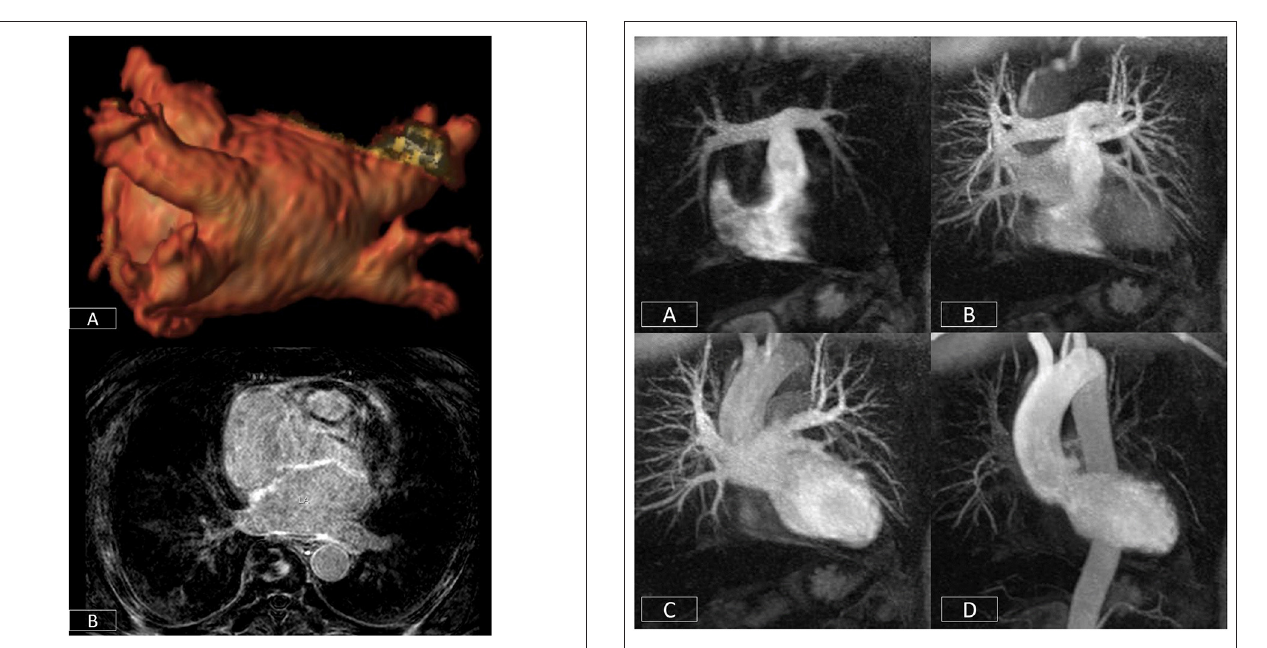
FIGURE 7 | Cardiovascular time resolved 3D-angiography. The bolus of contrast is imaged progressively as it passes from the right side of the heart (A) into the pulmonary arteries (B) , left atrium/ventricle (C) , and thoracic aorta (D) . This obviates the need to precisely time the contrast volume and enables the rapid visualization of different parts of the circulation with a single bolus of